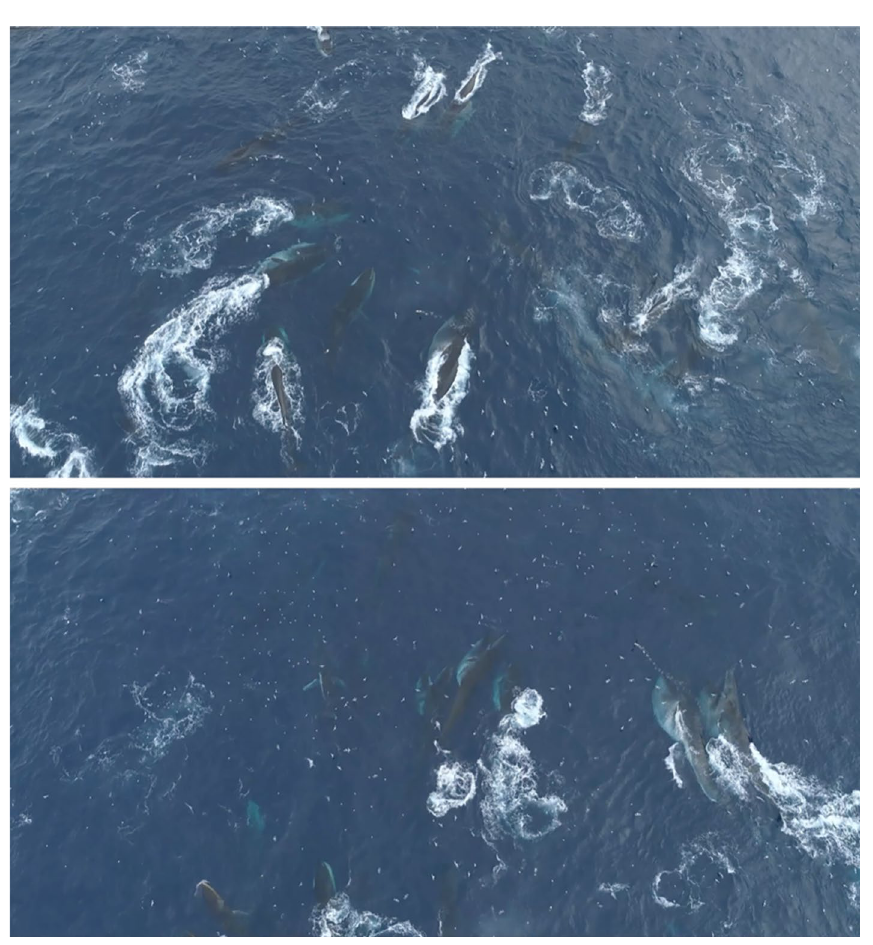
Figure 4. Close-up sections of the active feeding aggregation of ~ 70 fin whales. This aggregation was encountered during ship transit on RV Polarstern expedition PS112 in 2018 and filmed by drone. Fin whales are side-lunge feeding together at the surface. In the bottom panel a single humpback whale feeding with the fin whales is visible. ©BBC (OSM video